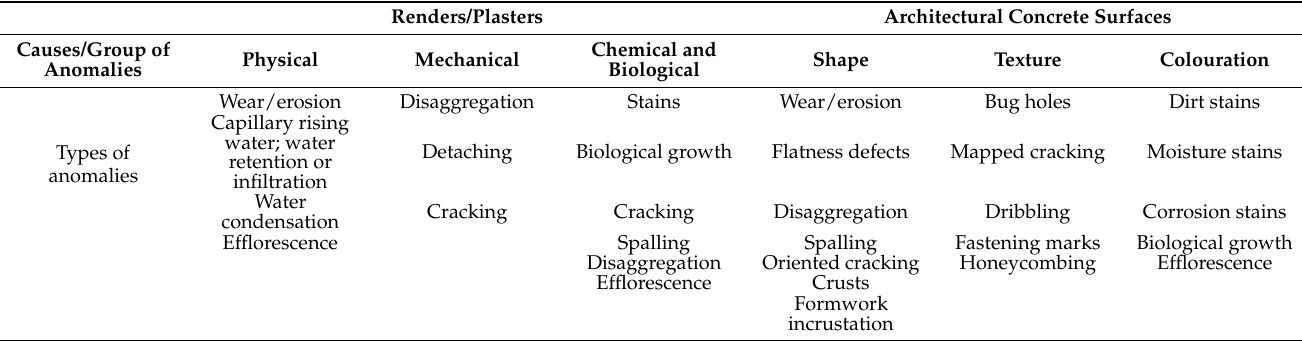
Table 3. Types, causes, and groups of anomalies related to renders, plasters, and architectural concrete surfaces. Renders/Plasters Architectural Concrete Surfaces Causes/Group of Anomalies